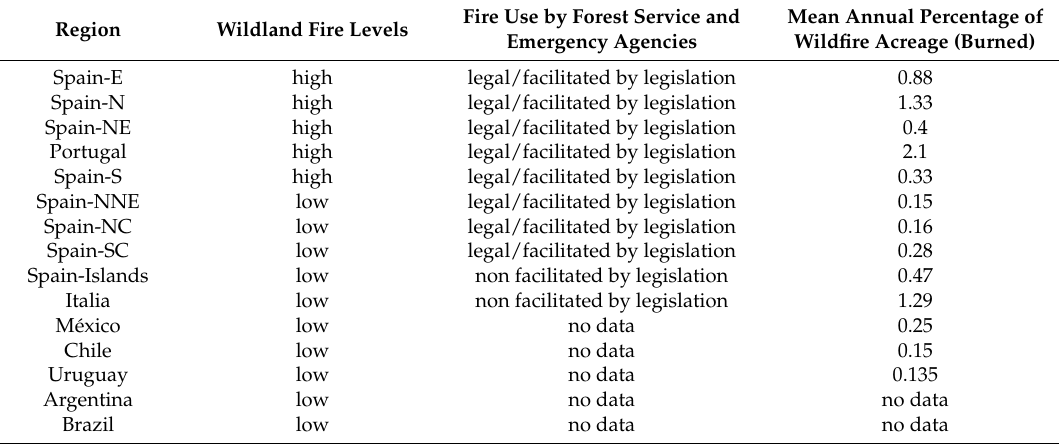
Table 5. Regions in two different categories, “High” and “Low” wildland fires levels.